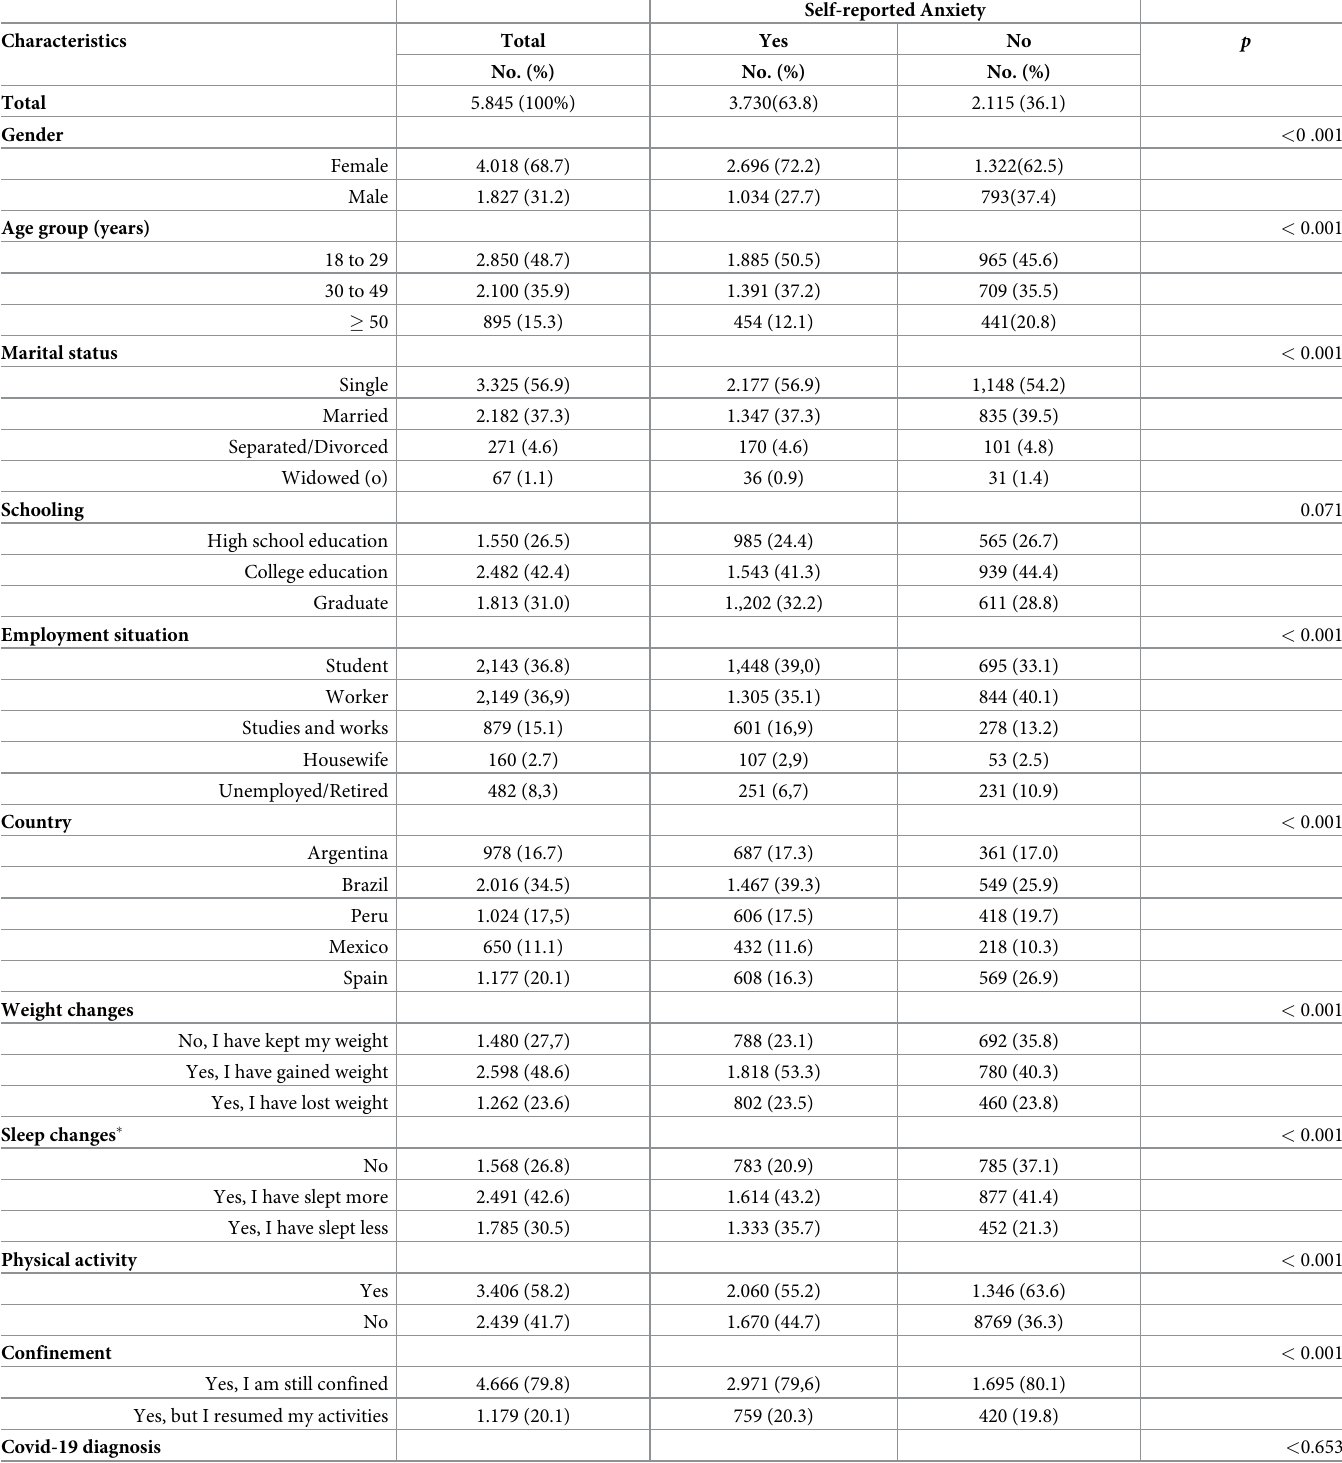
Table 1. Sociodemographic characteristics, lifestyle, confinement, and diagnosis of covid-19 during the confinement due to the first wave of covid-19 and preva- lence of anxiety in participants of the Ibero-American Study, 2020.